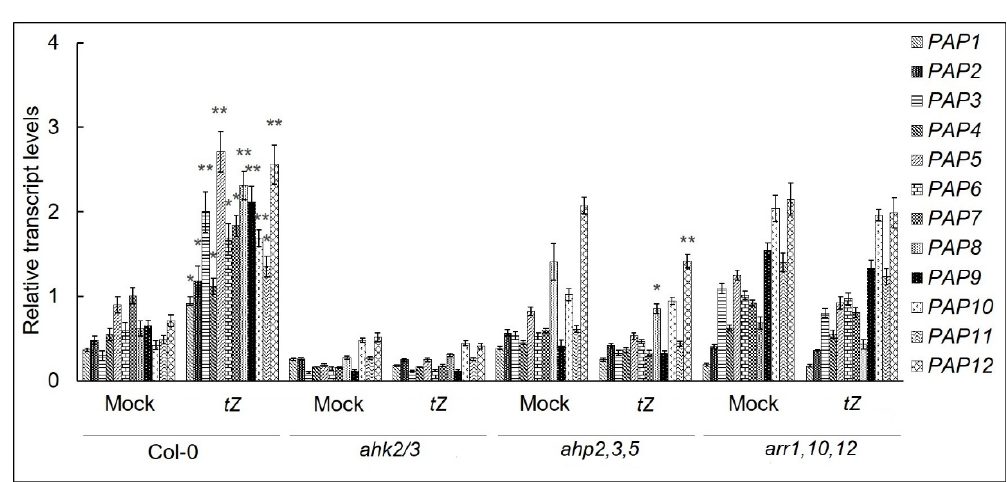
Figure 2. E ff ects of trans -zeatin (5 µ M, 3 h) on the transcript accumulation of PAP genes in 1-week-old wild type plants and CK signaling mutants. A. thaliana Col-0 and mutant plants were grown on MS medium in Petri dishes for 7 days under a 16 h light / 8 h dark photoperiod at 23 ◦ C with 100 µ E m − 2 s − 1 . Total RNAs were isolated from seedlings and analyzed by relative quantitative RT-PCR using UBQ10 and PP2A as internal standards. Data represent the means and SEs values of three independent biological replicates. Asterisks indicate significant di ff erences from the value of the respective mock control samples (* p < 0.05; ** p <